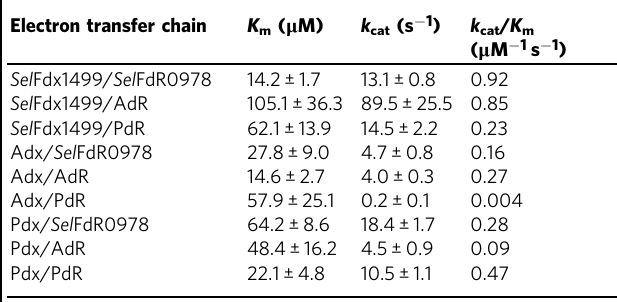
Table 1 Kinetic parameters for reduction of redoxins ( Sel Fdx1499, Adx, Pdx) by redoxin reductases ( Sel FdR0978, AdR, PdR) using cyt c as the electron acceptor a